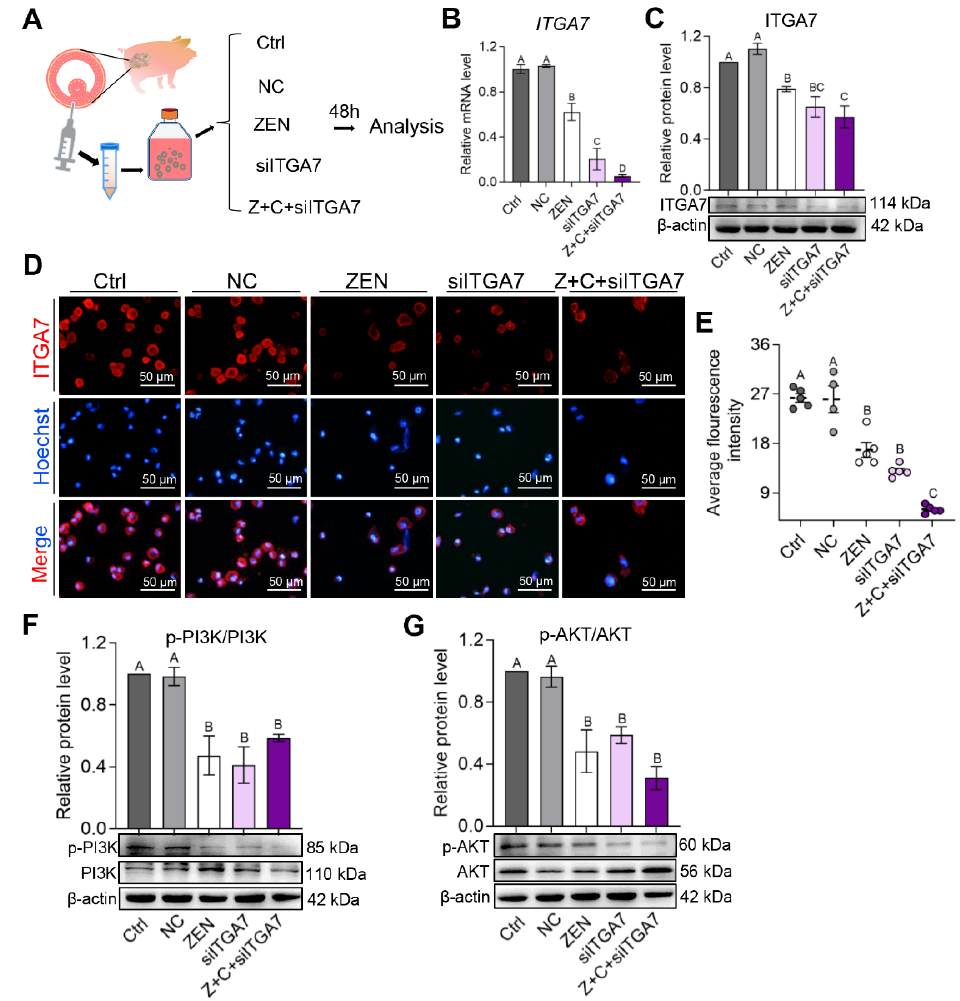
Figure 5. C3G plays an important role via the ITGA7-PI3K-AKT signaling pathway in pGCs. ( A ) Experimental scheme for examination of ITGA7 knock-down to determine its effects on the PI3K-AKT signaling pathway in pGCs. ( B , C ) The relative mRNA ( B ) and protein (( C ), β -actin as the internal reference) level of ITGA7 in pGCs between the Ctrl, NC, ZEN, siITGA7, and Z+C+siITGA7 groups; n = 3. ( D ) Immunostaining of ITGA7 (red) in pGCs between the 5 groups. Nuclei were counterstained with Hoechst (blue); scale bar = 50 µm. ( E ) Fluorescence intensity of ITGA7 in pGCs determined from images in ( D ); n = 5 or 4. ( F , G ) WB showing relative protein level of PI3K and p-PI3K ( F ), AKT and p-AKT ( G ); n = 3. All results are presented as mean ± SEM. All experiments were repeated at least 3 times. Labels (A, B, C) indicate significantly different values ( p < 0.01).